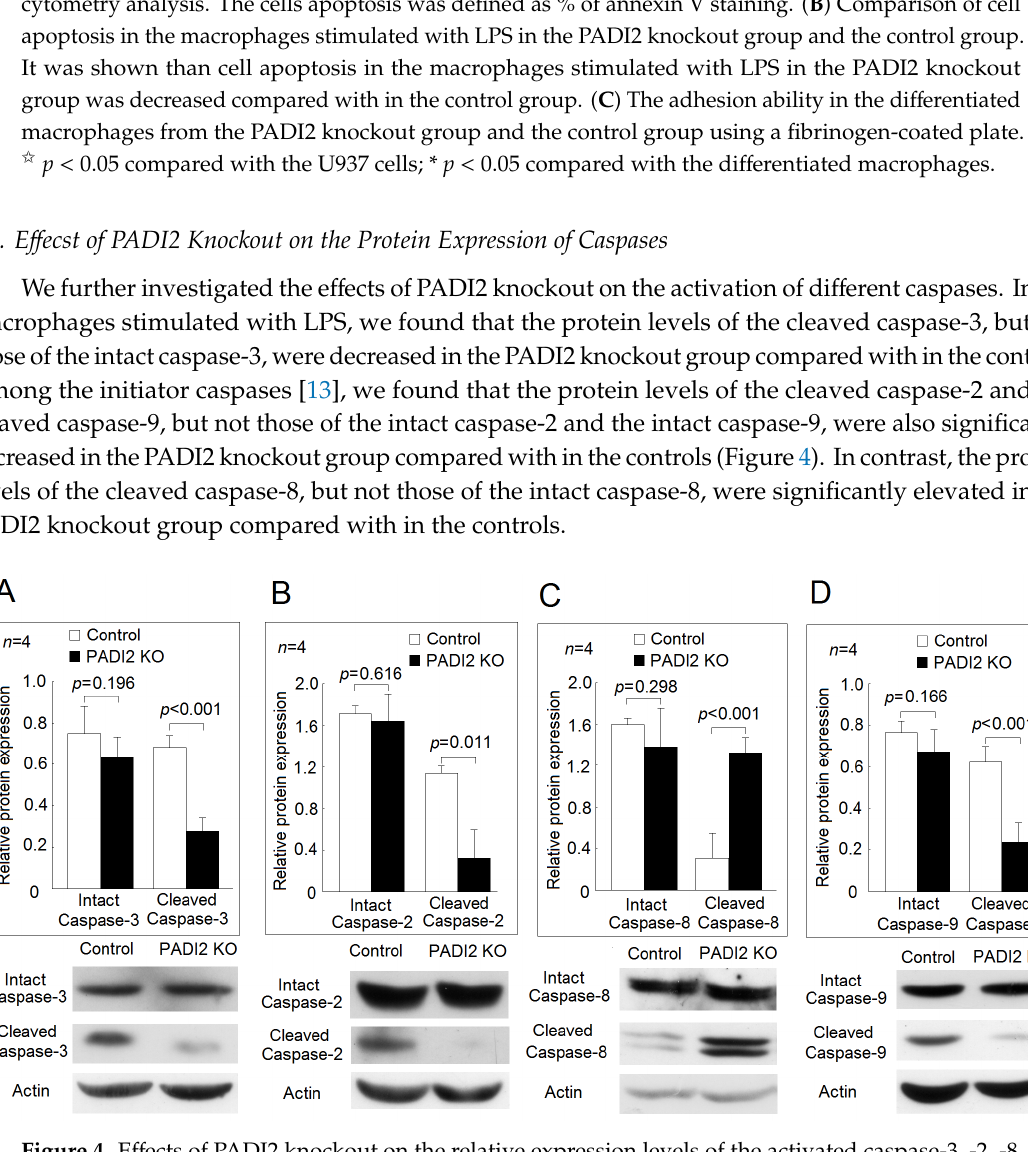
Figure 4. E ff ects of PADI2 knockout on the relative expression levels of the activated caspase-3, -2, -8, and -9. In the di ff erentiated macrophages stimulated with LPS, the protein expression levels of the intact caspases and the cleaved caspases were performed by Western blotting in the PADI2 knockout group and the control group. The relative protein expression was defined as the ratio of intact caspases or cleaved caspases to the actin band intensity: ( A ) caspase-3; ( B ) caspase-2; ( C ) caspase-8; ( D ) caspase-9.